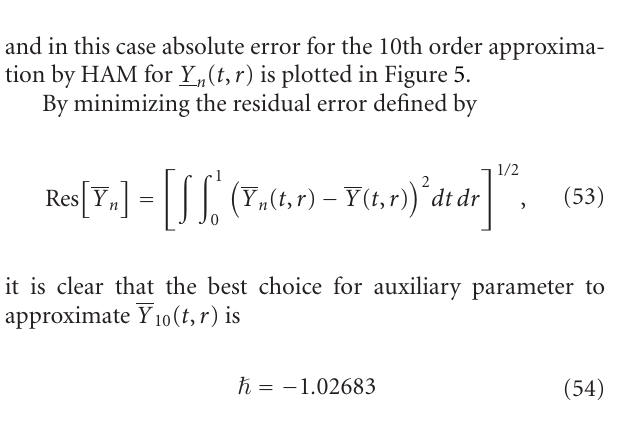
and in this case absolute error for the 10th order approxima- ( t , r ) is plotted in Figure 5. tion by HAM for Y n